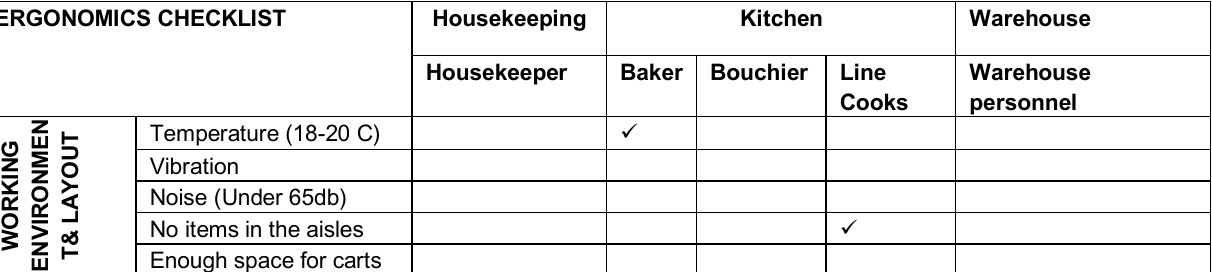
Table 4 : Workplace Analysis and